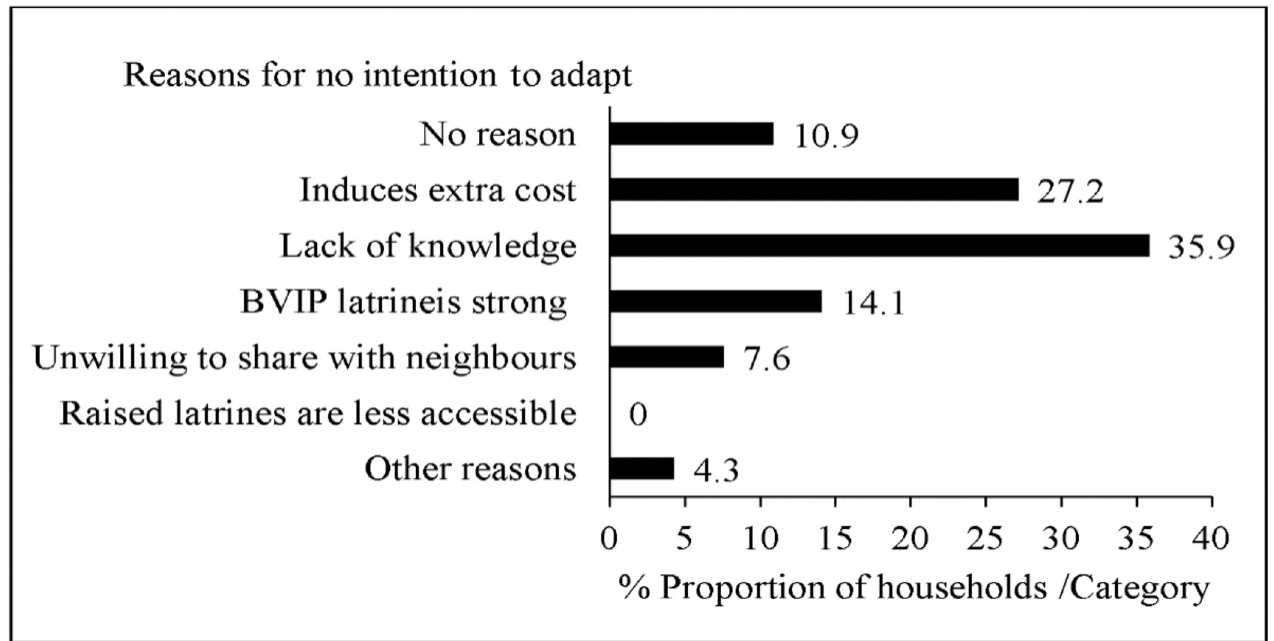
Fig 5. Reasons for no intention to adapt household BVIP latrines to climate changes in Mbire district, northern Zimbabwe, 2021 (n =